Question: Summarize what this figure shows in one sentence.
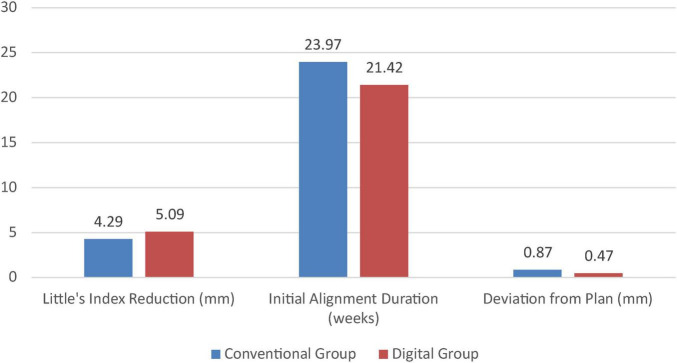
Answer: Comparison of clinical outcomes between treatment groups.